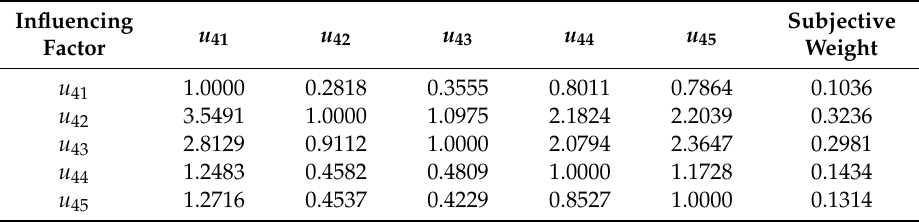
Table 21. The subjective weights of IED influencing factors.